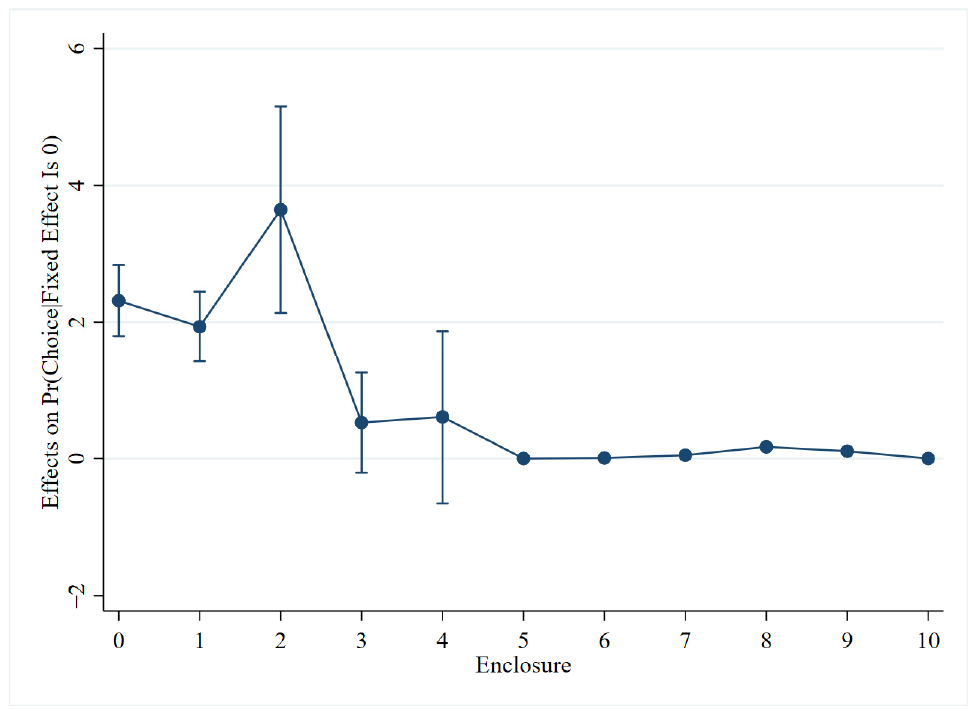
Figure 4. Marginal effect of green in different enclosure levels with 95% confidence levels.